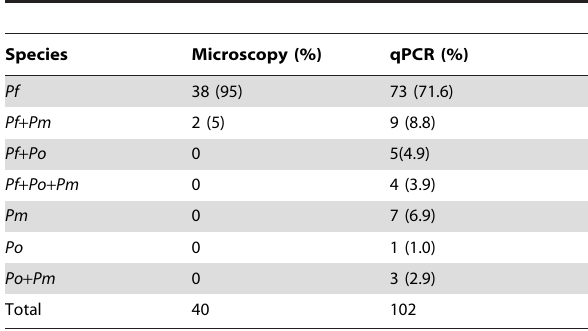
Table 3. The number and percentage of Plasmodium parasite species detected by microscopy and